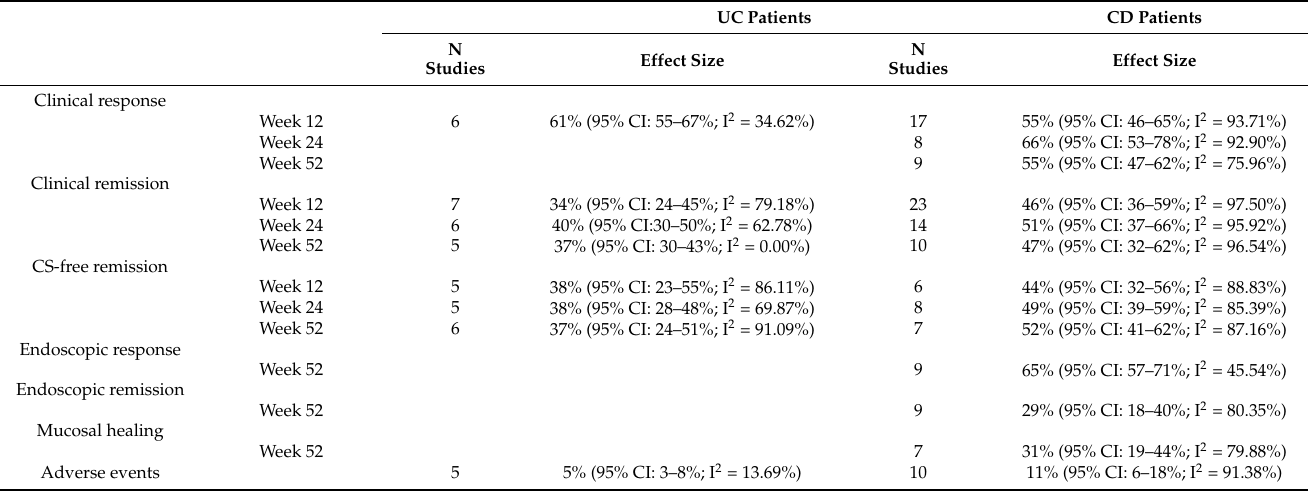
Table 2. Summary of the main findings in patients with ulcerative colitis and Crohn’s disease.